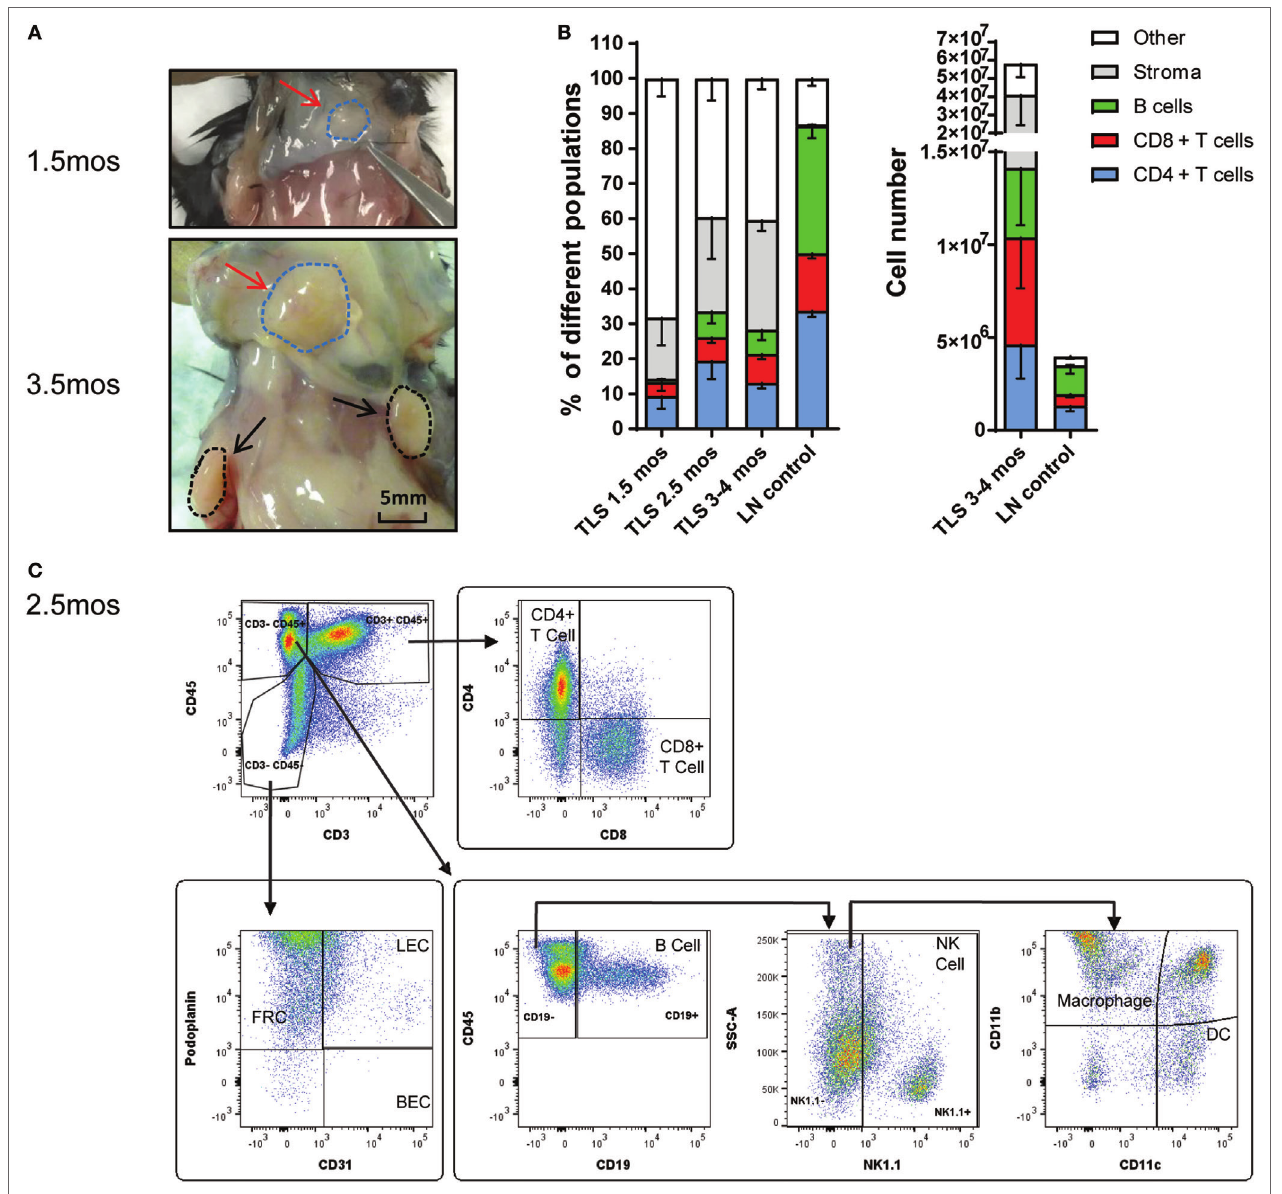
FigUre 2 | Induction of tertiary lymphoid structures (TLSs). (a) Representative photographs of 1.5- and 3.5-month TLSs (red arrows and blue circles) and adjacent brachial lymph nodes (LNs) (black arrows and circles). Scale bar denotes 5 mm. (B) Percentages and cell numbers of different cell populations in LN stroma-induced TLSs at indicated time points ( n = 5 for 1.5 months, n = 3 for 2.5 months, n = 13–27 for 3–4 months) and LNs (control, n = 13–16) were analyzed by flow cytometry. Other: NK cells, macrophages, DCs, and other undefined cells. Stroma: fibroblastic reticular cells (FRCs), lymphatic endothelial cells (LECs), and blood endothelial cells (BECs). (c) Flow cytometry analysis of 2.5-month LN stroma-induced TLSs. Data are presented as mean ±